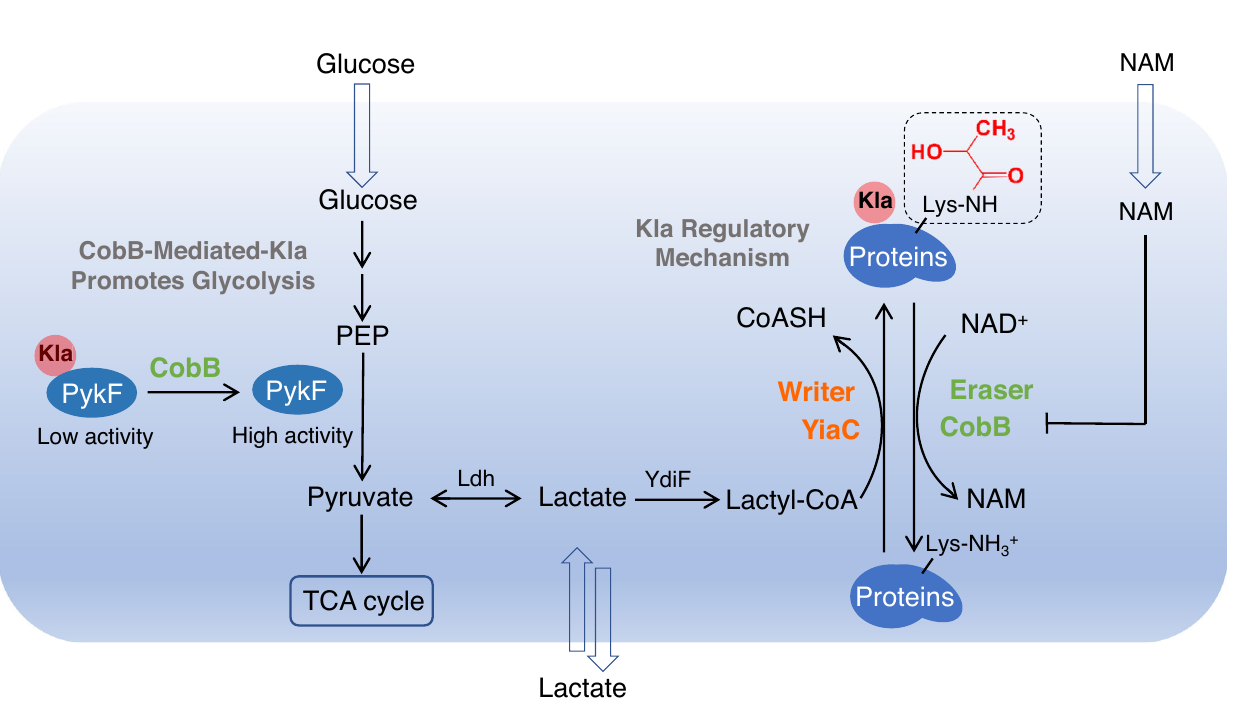
Fig. 6 | CobB in fl uence PykF activity, glycolysis, and cell growth by erasing K382la.a TheMS/MSspectrumofpeptide(LDAPLIVVATQGGK(la)SAR,PYKF)from proteome of Δ cobB . b The MS/MS spectrum of synthetic peptide (LDA- PLIVVATQGGK(la)SAR). c Selection the same expression of recombinant PykF for overexpression strains by immunoblotting with his tag antibody. d Measurement growth curve of PykF-overexpressing E. coli strains (pPykF, pPykF K382Q , and pPykF K382R ) cultured in LB medium at 37°C with 96-well plates. e Measurement of theintracellularactivityofPykFofstrainsrelatedto d . f Measurementgrowthcurve of pPykF, pPykF K382Q , and pPykF K382R strains cultured in M9 medium with 1% glu- couse at 37°C with 96-well plates. g Measurement of the intracellular activity of PykF ofstrains relatedto f . h Measurement growth curve of pPykF,pPykF K382Q , and pPykF K382R strains cultured in M9 medium with 1% pyruvate at 37°C with 96-well plates. i CobBcatalyzeddelactylationofPykFK382lainvitro.SyntheticPykFK382la peptide (LDAPLIVVATQGGK(la)SAR) was used as the substrate for CobB